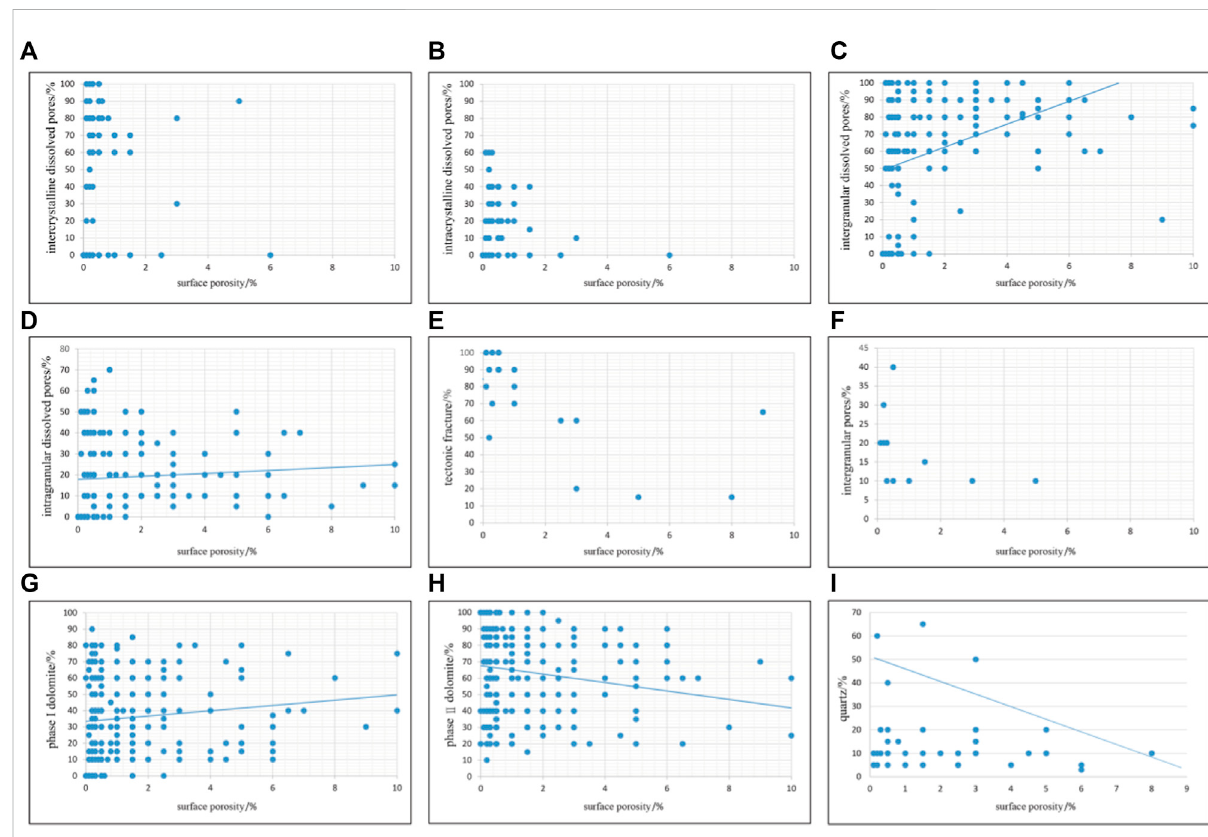
FIGURE 8 Surface porosity distribution under various diagenesis of the Longwangmiao Formation in the study area. (A) Relationship between intercrystalline dissolved pores and surface porosity; (B) Relationship between intracrystalline dissolved pores and surface porosity; (C) Relationship between intergranular dissolved pores and surface porosity; (D) Relationship between intragranular dissolved pores and surface porosity; (E) Relationshipbetweentectonicfractureandsurfaceporosity; (F) Relationshipbetweenintergranularporesandsurfaceporosity; (G) Relationship between phase I dolomite and surface porosity; (H) Relationship between phase Ⅱ dolomite and surface porosity; (I) Relationship between hydrothermal quartz and surface